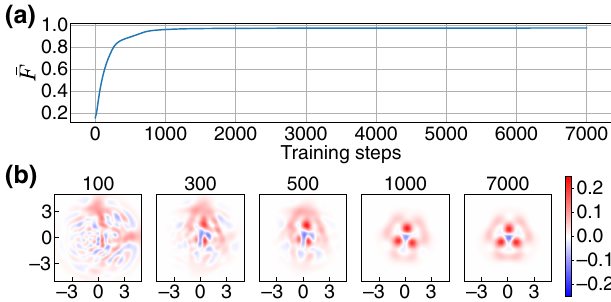
FIG. 8. (a) Learning curve for results in Fig. 6. (b) Wigner functions of ˆ ρ code at different iterations during training, which shows a relatively good convergence after a few thousand